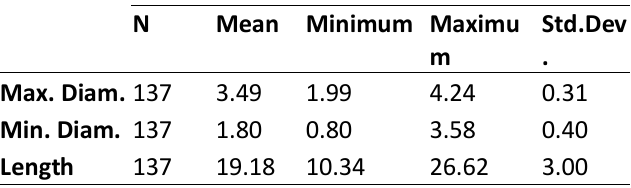
Table 4: Measurements recorded on the Dentalium sp. From